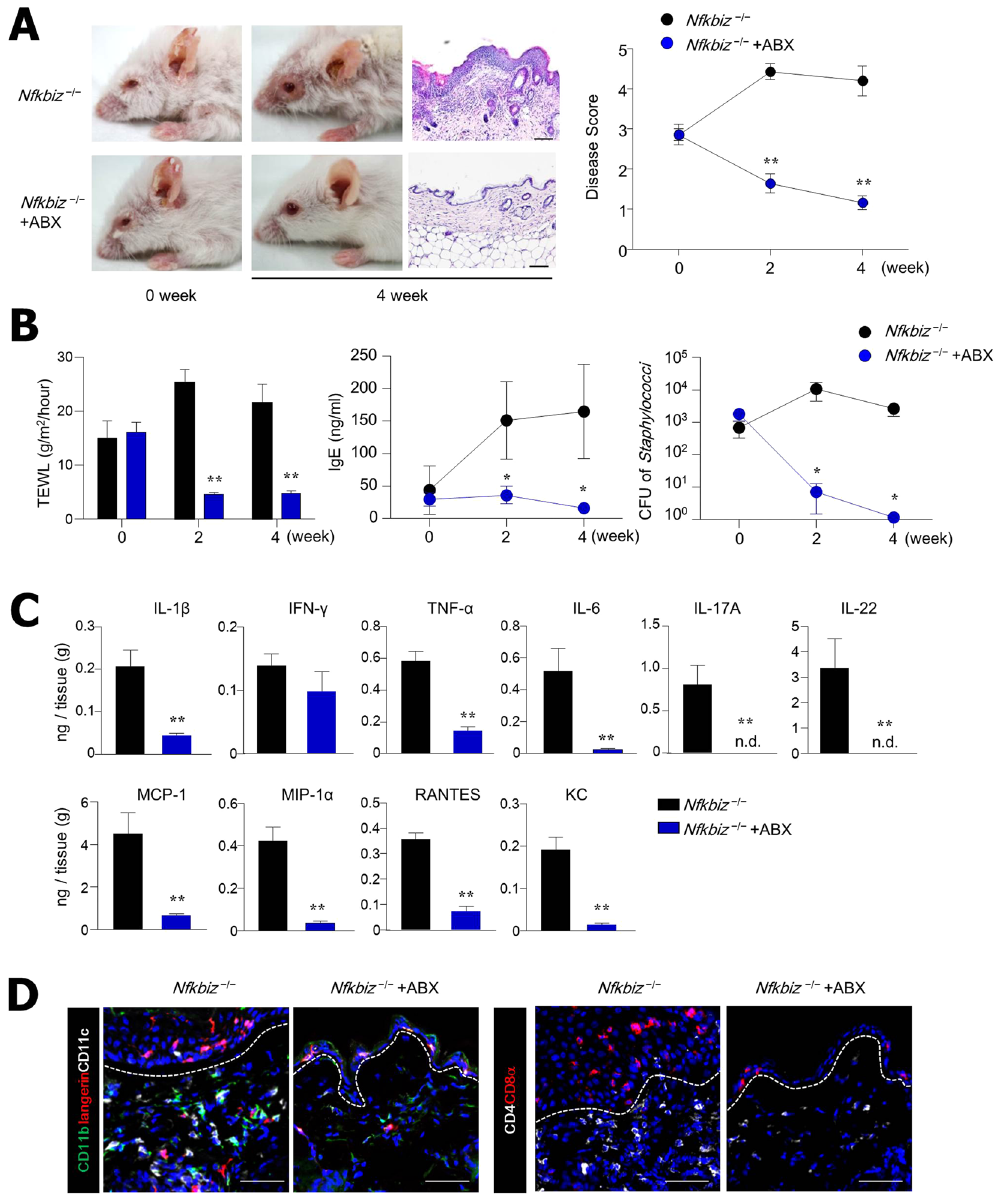
Figure 4. Antibiotic (ABX) treatment eliminates skin inflammation. ( A ) Representative skin phenotype and histology of skin biopsy from untreated (water alone) and ABX-treated Nfkbiz − / − mice at age 6 weeks. Scale bar = 50 μ m. ( B ) TEWL, serum IgE levels, and colony-forming units (CFU) of Staphylococcus species. ( C ) Cytokine and chemokine levels in skin homogenate. ( D ) Confocal microscopy of skin biopsies. Scale bar = 50 μ m. Data are representative of three independent experiments. All data are mean ± s.e.m. * p < 0.05, ** p <